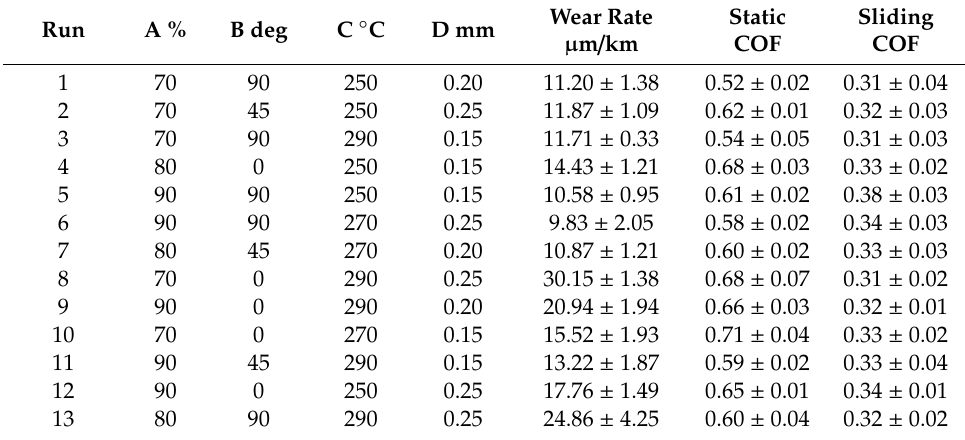
Table 4. Overview of the experimental design and measured tribological parameters. Static COF: coe ffi cient of static friction, Sliding COF: coe ffi cient of sliding friction. Run A % B deg C ◦